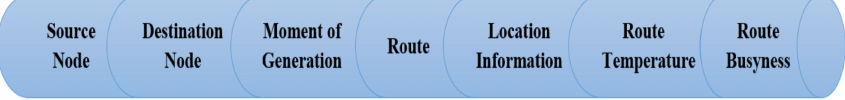
Figure 7. The contents of